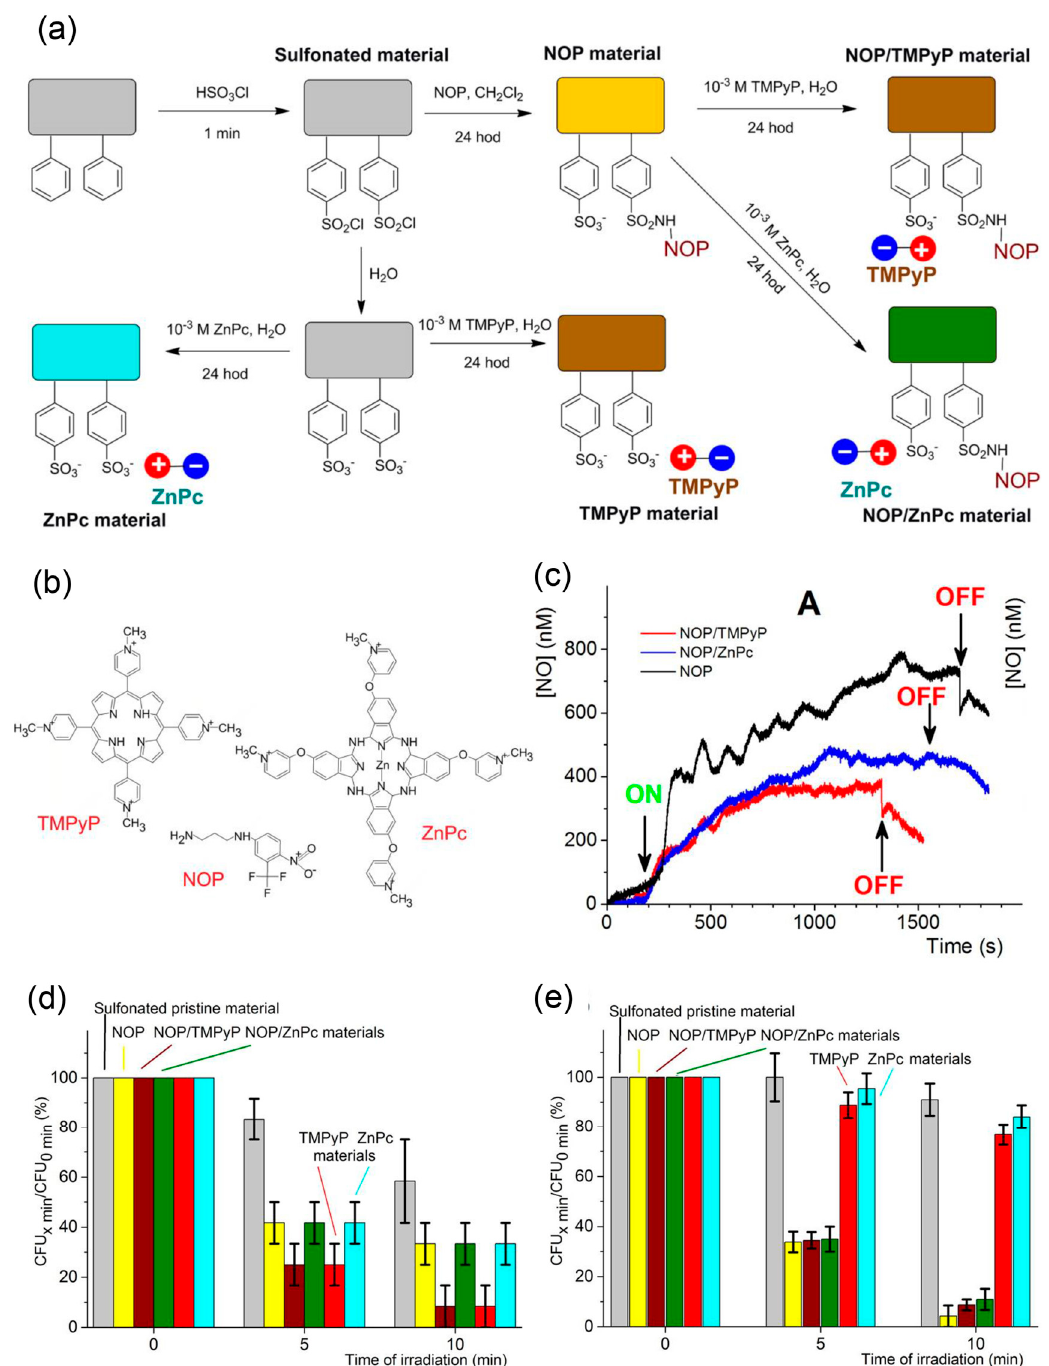
Figure 8. Preparation, NO releasing behavior, and antibacterial properties of photoactive nanofiber materials. ( a ) Schematic diagram of the preparation protocol for the photoactive nanofiber materials. ( b ) Structures of the photoactive compounds used in this work: NO photodonor (NOP), tetracationic TMPyP, and tetracationic ZnPc photosensitizers. ( c ) Amperometric detection of the NO photoreleased from the surface of NOP (black trace), NOP / TMPyP (red trace), and NOP / ZnPc(blue trace) materials. ( d ) Surface photoantibacterial activity of NOP, NOP / TMPyP, NOP / ZnPc, TMPyP, and ZnPc materials against E. coli compared with sulfonated pristine nanofiber material. ( e ) Space photoantibacterial activity of NOP, NOP / TMPyP, NOP / ZnPc, TMPyP, and ZnPc materials against E. coli compared with sulfonated pristine nanofiber material. Reproduced with permission from [59]. Copyright 2015, American Chemical